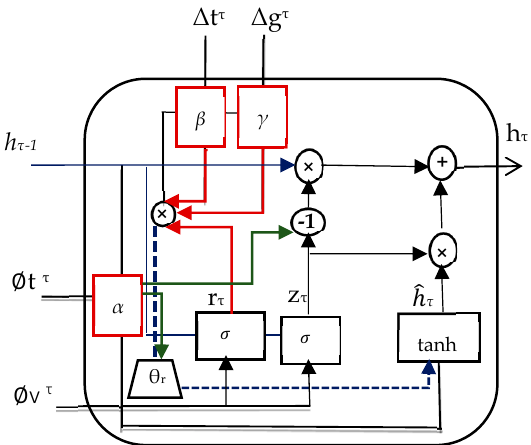
Figure 4. EAGRU’s recurrent layer block diagram with three additional attention gates ( α , β , and γ ).